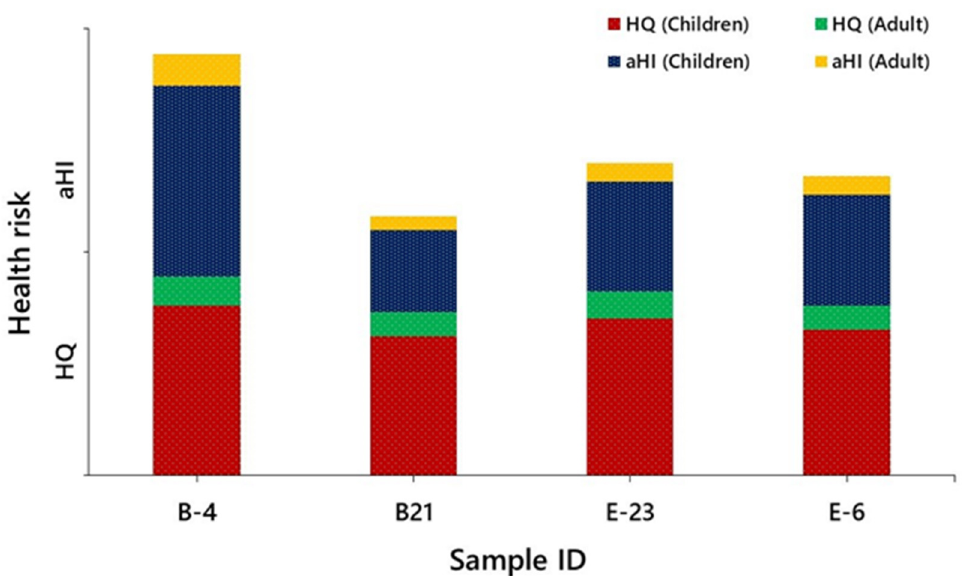
Figure 2. Non-cancer acute health risk (aHI) and chronic hazard quotient (HQ) values for children and adults due to the likely consumption of pesticide-contaminated green vegetables. B = country bean; E = eggplant; six samples ( n = 6) of each vegetable collected from every location.